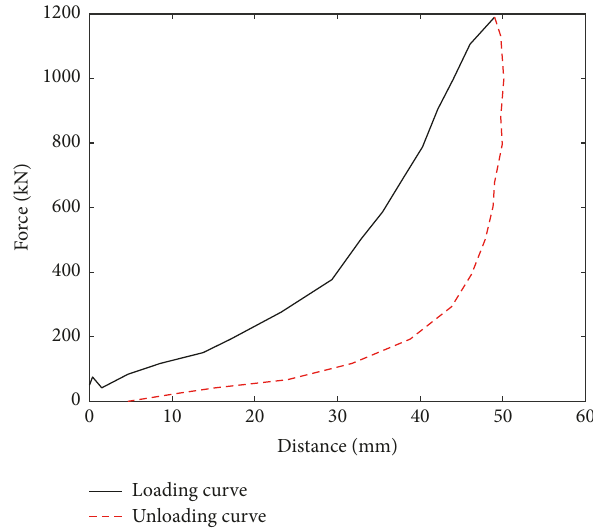
Figure 7: Performance curve of the buffer of the intermediate railway